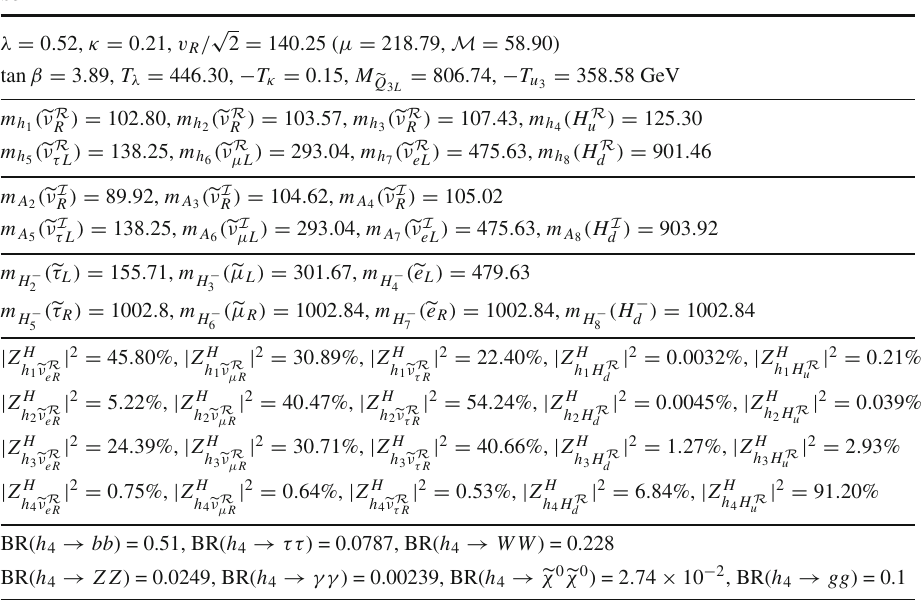
Table 14 The same as in Table. 12, but for the benchmark point S3-2h1 with several singlet-like scalars h 1 , 3 , 4 of masses close to the mass of the SM-like Higgs h 5 . Their branching ratios are shown in the sixth-nineth boxes, and their decay widths in the tenth